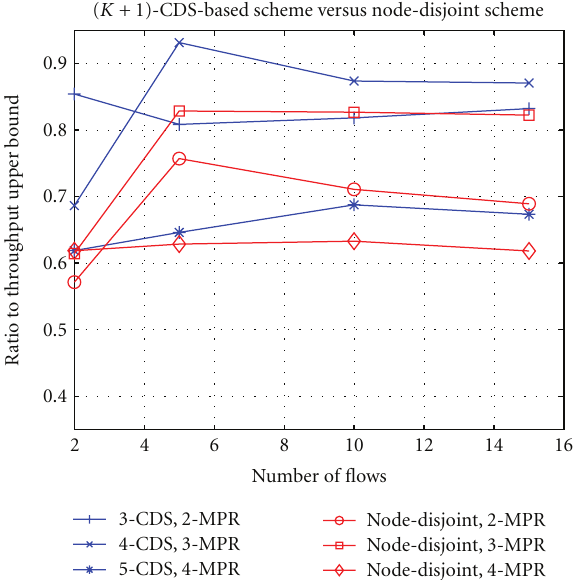
Figure 11: The heuristics’ e ffi ciency, subject to upper bound.